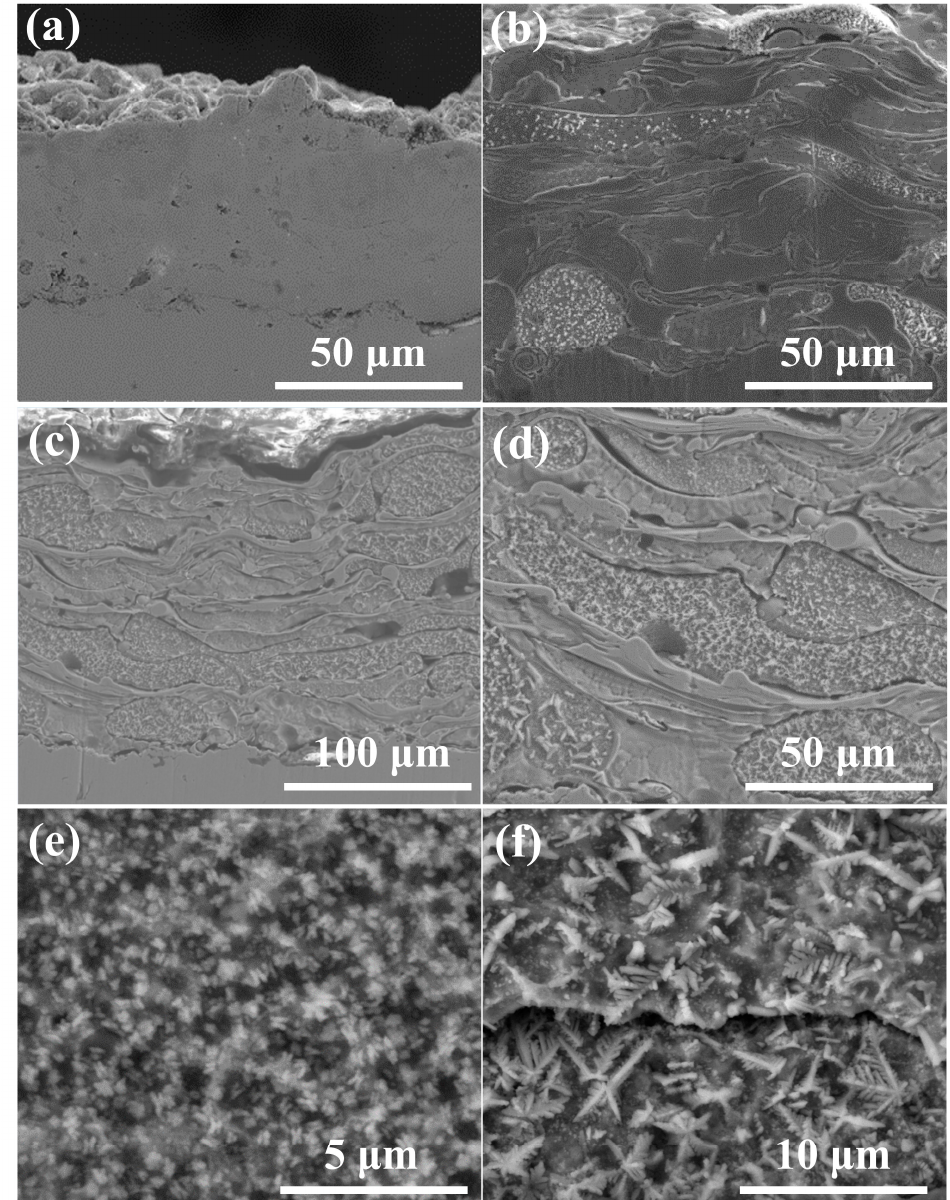
Figure 6. The cross section views of NiCrBSi coating and retained phases after acid accelerated corrosion. ( a ) Cross-sectional morphology of as-sprayed NiCrBSi coating, ( b ) after corrosion for 30 min, ( c ) after corrosion for 24 h, ( d ) high magnification of ( c ), ( e ) nano-sized grain region after corrosion for 24 h, and ( f ) “fish-bone like” or “leaf-like” grain region after corrosion for 24 h. After corrosion, it can be seen that most of the region is smooth, indicating high amorphous content. However, there is also some spherical regions, which could be semi- melted or unmelted feedstocks not having enough driving force for amorphous formation. These hard particles are uniformly distributed in the amorphous coatings and can be corroded preferentially. Figure 6c,d reveal the cross-sectional morphology of the NiCrBSi coating after long time and severe corrosion. The microstructure of the coating can be clearly observed from the experimental results. The grains in the coating are mainly composed of about 200 nm grains and 3–8 µ m “fish-bone like” or “leaf-like” grains shown in Figure 6e,f, respectively, which are identical to those in Figure 5b–d. The different phase components are caused by varied local aggregation